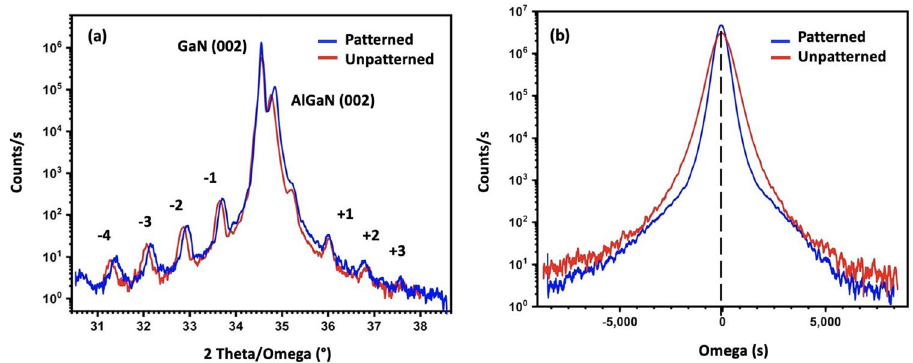
Figure 2. ( a ) High resolution X-ray diffraction 2θ − ω scans of the two grown samples. ( b ) High resolution X-ray diffraction ω-scans of the two grown samples along the GaN (0002) reflections.